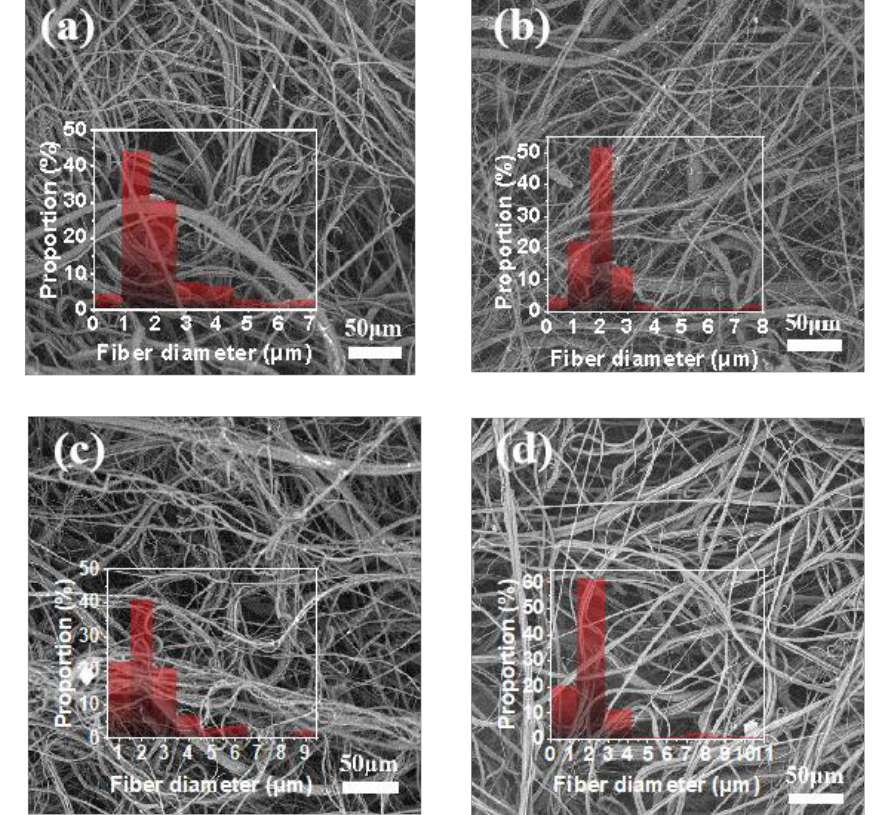
Figure 3. SEM images and fiber diameter distributions of the as ‐ produced nonwovens with different Si 3 N 4 content: ( a ) 0.0%, ( b ) 0.6%, ( c ) 0.8% and ( d ) 1.0%. Si 3 N 4 content: ( a ) 0.0%, ( b ) 0.6%, ( c ) 0.8% and ( d )